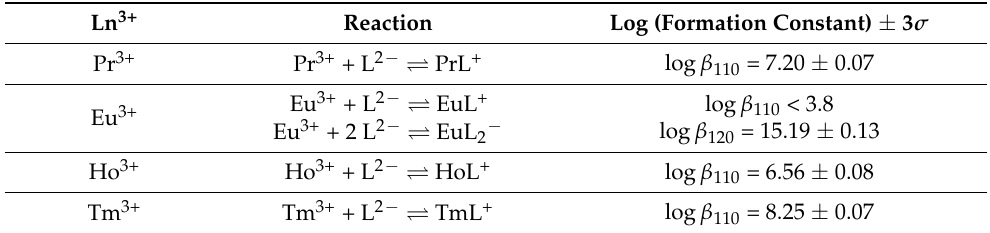
Table 3. Summary of Ln 3+ /harzianic acid (H 2 L) formation constants. σ denotes the estimated standard deviation.